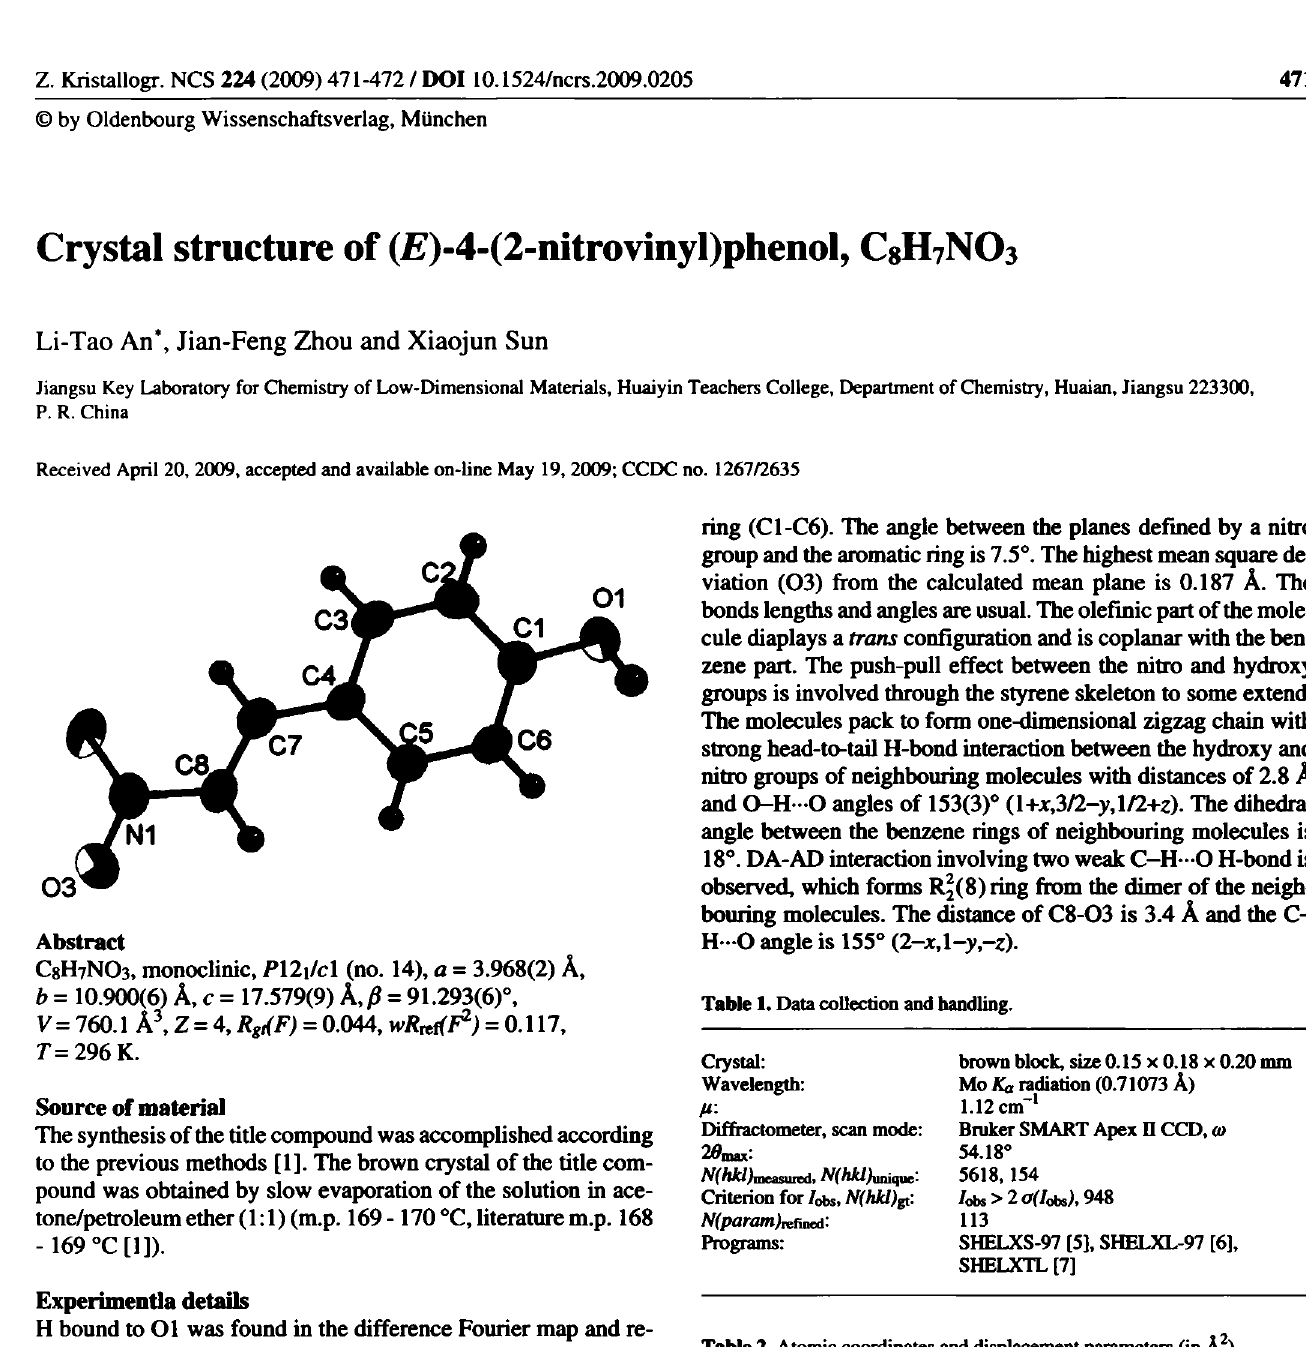
Table 2. Atomic coordinates and displacement parameters (in Â 2 ).